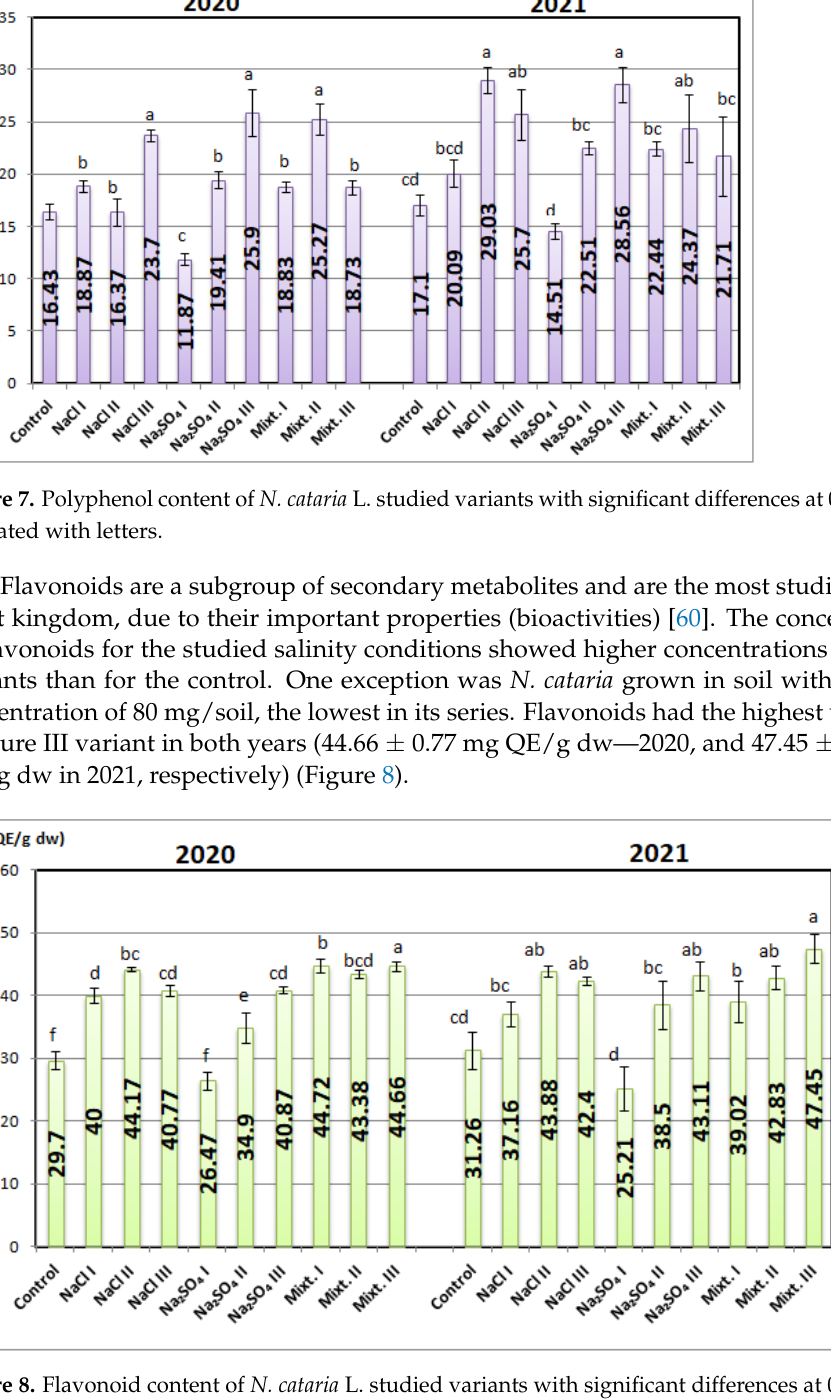
Figure 9. Antioxidant activity of N. cataria L. studied variants with significant differences at 0.001 level indicated with letters. The similarity between the polyphenol content of variants and antioxidant activity is due to the fact that polyphenols are powerful antioxidants, their production having the purpose of mediating the scavenging harmful effects of ROS under salinity stress. The synthesis of polyphenols and flavonoids is stimulated as a mechanism of plant tolerance against salinity stress, as evidenced by and reported in many studies [42,43,46–48,54,61]. Flavonoids, polyphenols, and antioxidant activity decreased for a small concentration of Na 2 SO 4 , while higher salt stress stimulated the production of active compounds for all